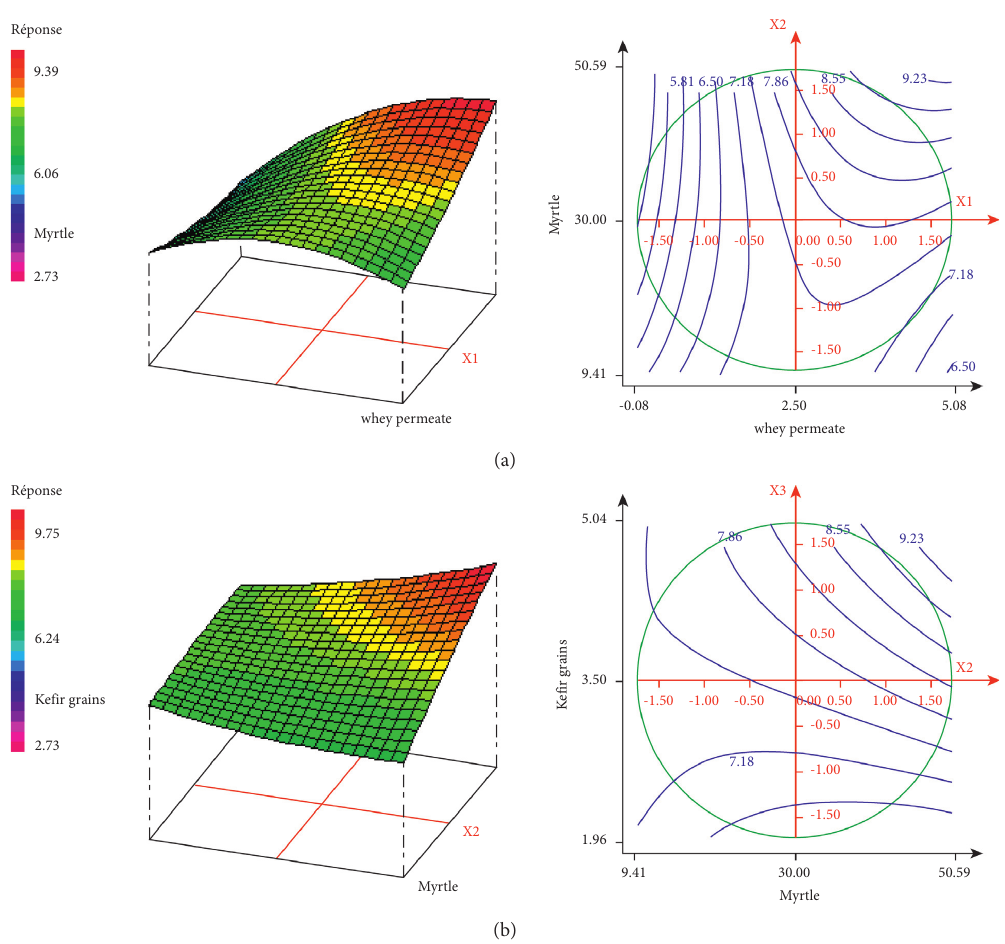
Figure 4: Response surface and contour plots representing the effect of WP and MJ (a) and the effect of MJ and KG (b) on LAB count ( X WP (% w/v); X 2 : MJ (% w/v); X 3 : KG (%